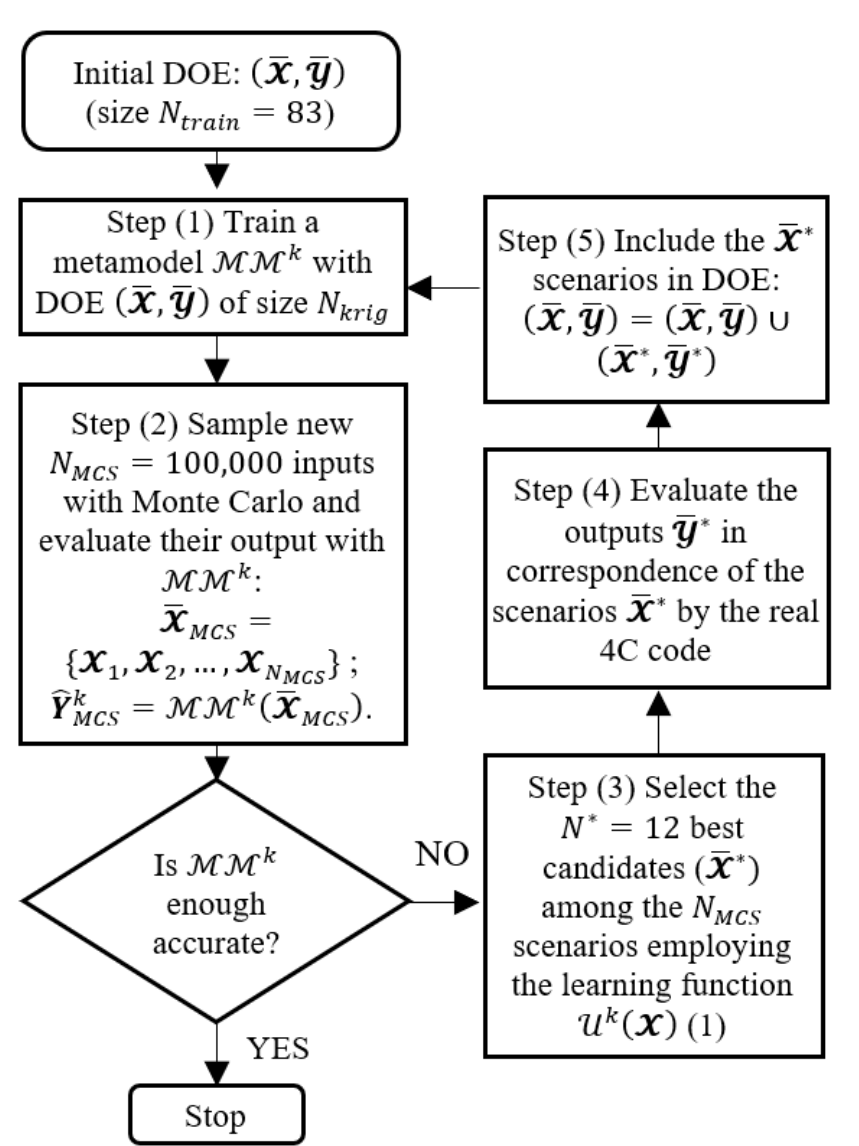
Figure 3. Flowchart of the AK-MCS